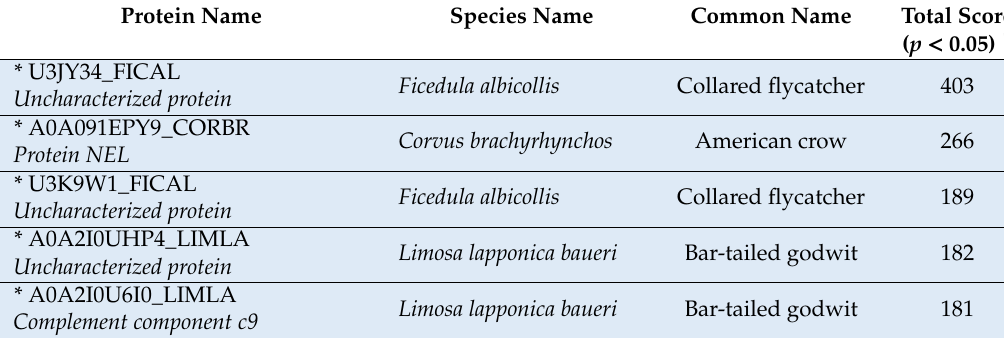
Ions score is − 10. * Log (P), where P is the probability that the observed match is a random event. Individual ions scores > 40 indicated identity or extensive homology ( p < 0.05). Protein scores were derived from ions scores as a non-probabilistic basis for ranking protein hits. Table 1. Deiminated protein hits identified by F95 enrichment in plasma of northern giant petrel ( Macronectes halli ). Deiminated proteins were isolated by immunoprecipitation using the pan- Table 2. Deiminated proteins identified by F95 enrichment in plasma of south polar skua ( Stercorarius deimination F95 antibody. The F95-enriched eluate was analysed by LC–MS/MS and peak list files maccormicki ). Deiminated proteins were isolated by immunoprecipitation using the pan-deimination were submitted to mascot. Peptides matching with Aves_class_20190709 (876,224 sequences; F95 antibody. The F95-enriched eluate was analysed by LC–MS / MS and peak list files were submitted 364,491,521 residues) are shown and total score is reported. Protein hits with Aves are indicated, to mascot. Peptides matching with Aves_class_20190709 (876,224 sequences; 364,491,521 residues) are including species name. Protein hits which were identified as deiminated in northern giant petrel listed and total score is reported. Protein hits with Aves are indicated, including species name. Protein only, and not in wandering albatross or south polar skua are listed first and highlighted in light green hits which were identified as deiminated in south polar skua only, and not in northern giant petrel and with an asterix (*). For full LC–MS/MS data analysis, see Supplementary Table or wandering albatross are listed first and highlighted in light blue and with an asterix (*). For full LC–MS / MS data analysis, see Supplementary Table S2.